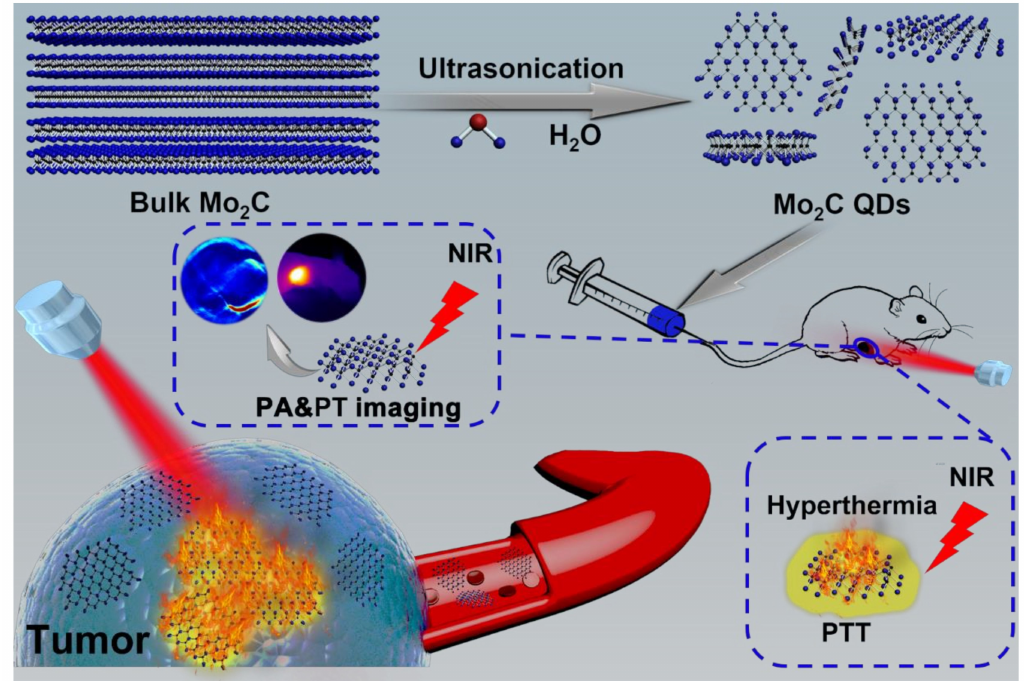
Figure 1. Schematic diagram of liquid exfoliation of molybdenum carbide quantum dots (Mo 2 C QDs) and in vivo photoacoustic (PA)/photothermal (PT) imaging-guided photothermal therapy (PTT) for